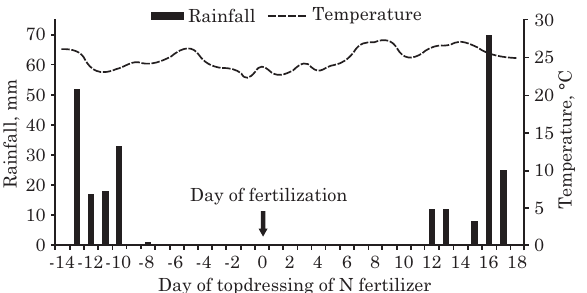
Figure 1. Rainfall during the evaluation of NH 3 volatilization .